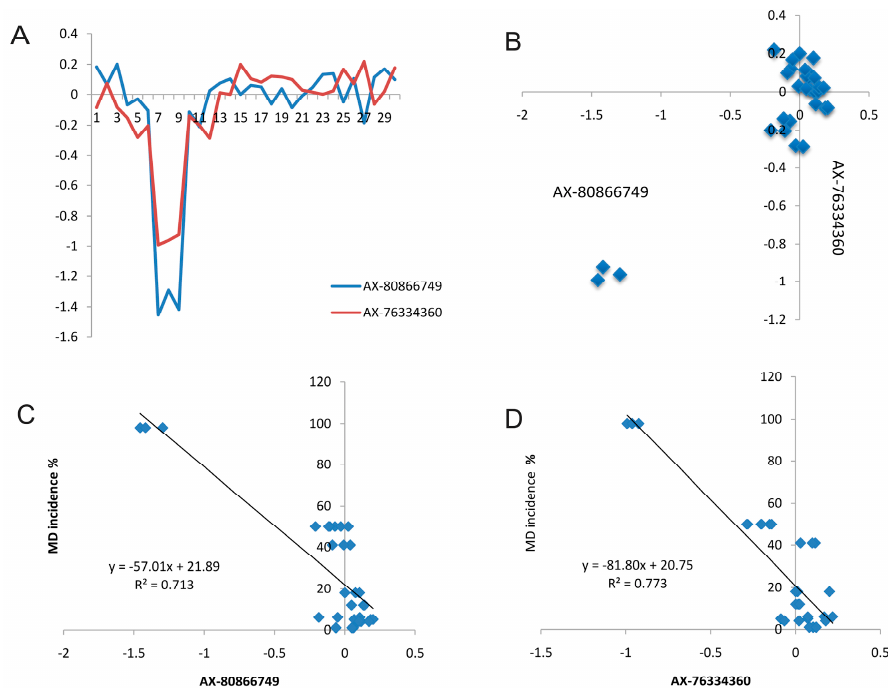
Figure 4. ( A ) Distribution of mean log 2 Ratios of two deletions within 30 individuals of 10 inbred chickens lines. X-axis: individual sample number (Number 7, 8 and 9 are Line 72 individuals), Y-axis: mean log 2 Ratio; ( B ) Scatter plot of the mean log 2 Ratios for the same two deletions shows significant correlation between them; ( C ) Linear regression between the average MD incidences for each line and average marker intensities for CNV1 (deletion at AX-80866749); and ( D ) Linear regression between the average MD incidences for each line and average marker intensities for CNV2 (deletion at AX-76334360).